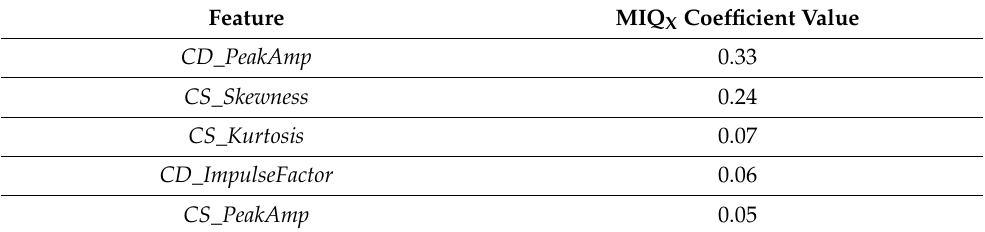
Table 3. Fundamental features of pressure signals.